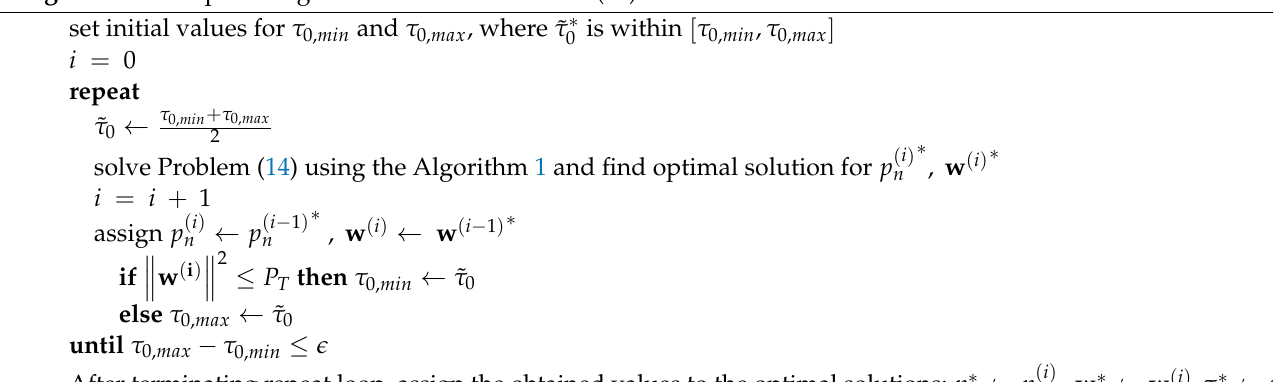
is within [ τ 0, min , τ 0, max ] 0